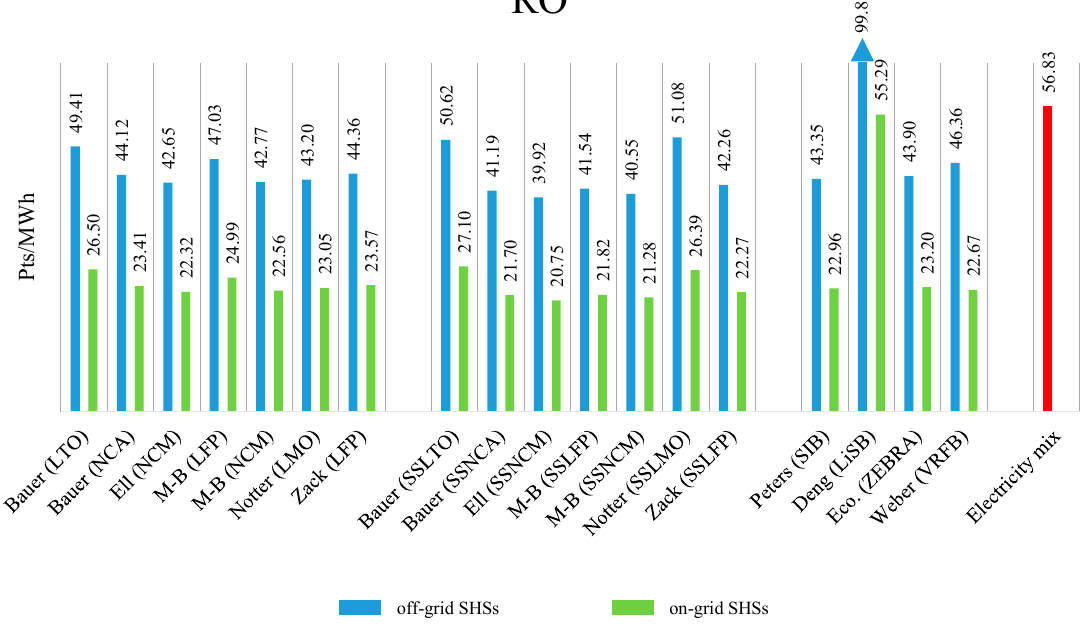
Figure 11. LCA impact values of SHSs in Portugal as single scores.